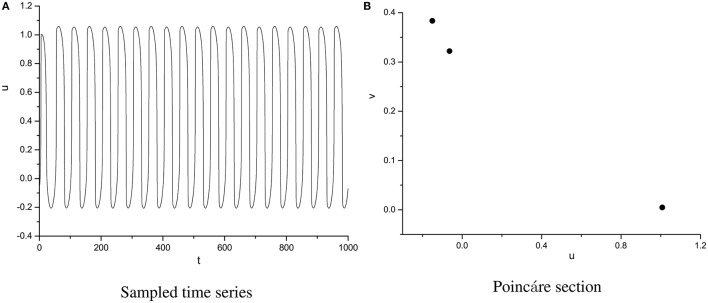
Sampled time series (A) and its Poincáre section (B) as ω = 0.1256.